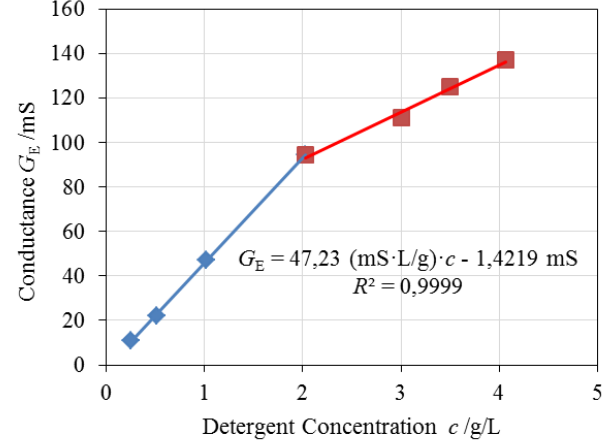
Figure 13. Dependence of the conductance on detergent concentra-